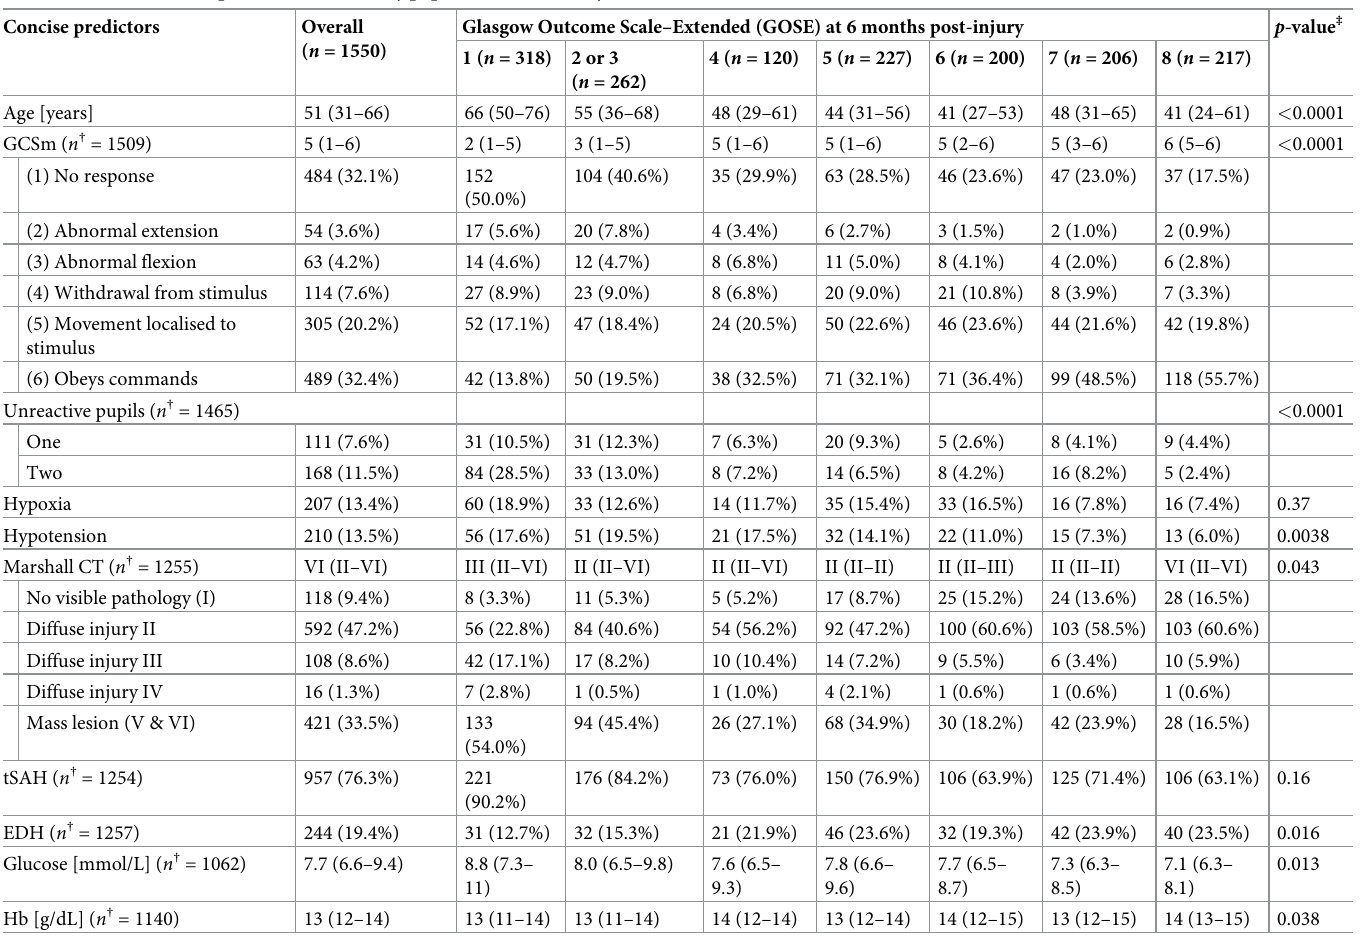
Table 2. Concise baseline predictors of the study population stratified by ordinal 6-month outcomes. Concise predictors Overall ( n =